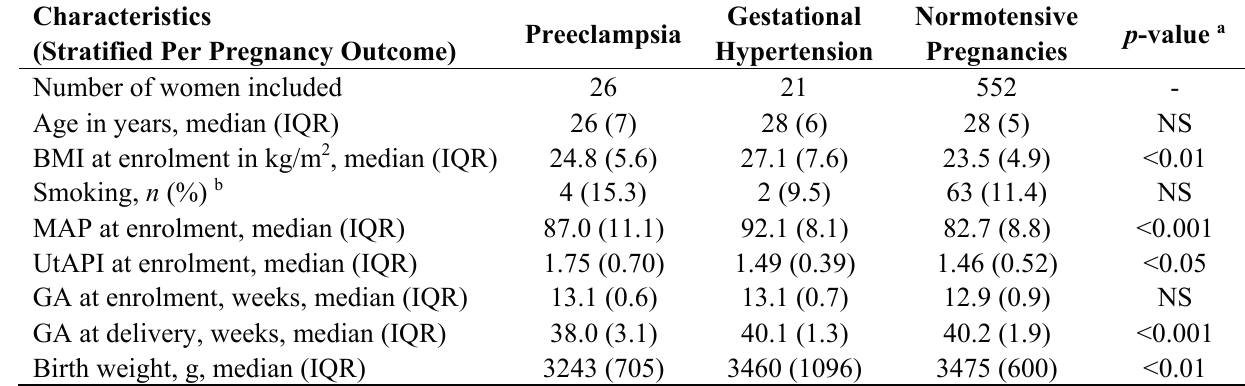
Table 1. Characteristics of the study participants at time of enrolment related to pregnancy outcome.